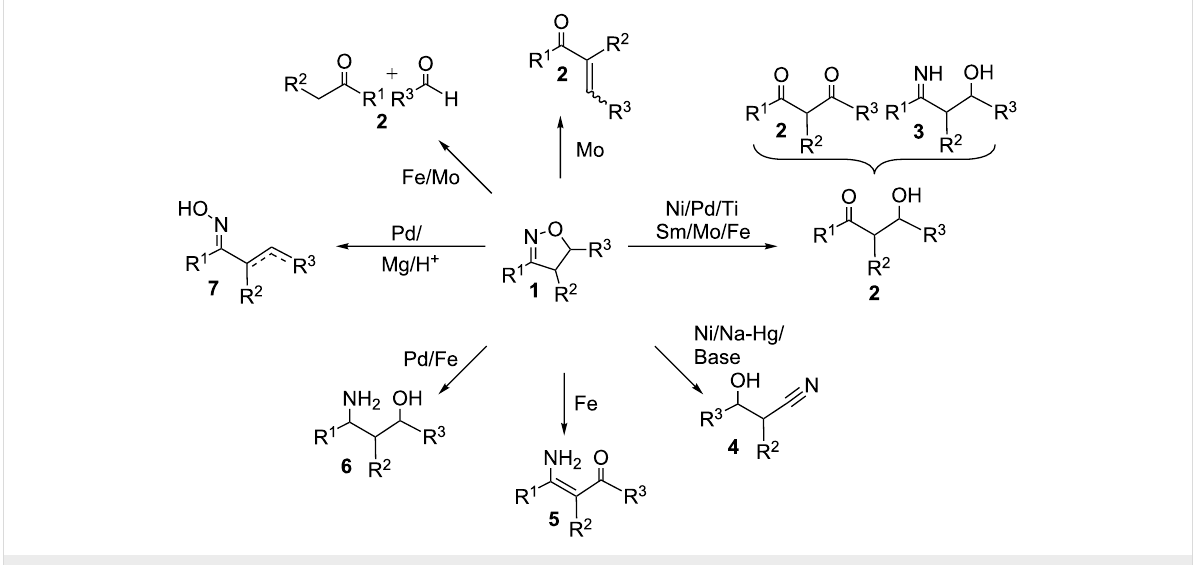
Scheme 1: Cleavage reactions of 2-isoxazoline 1